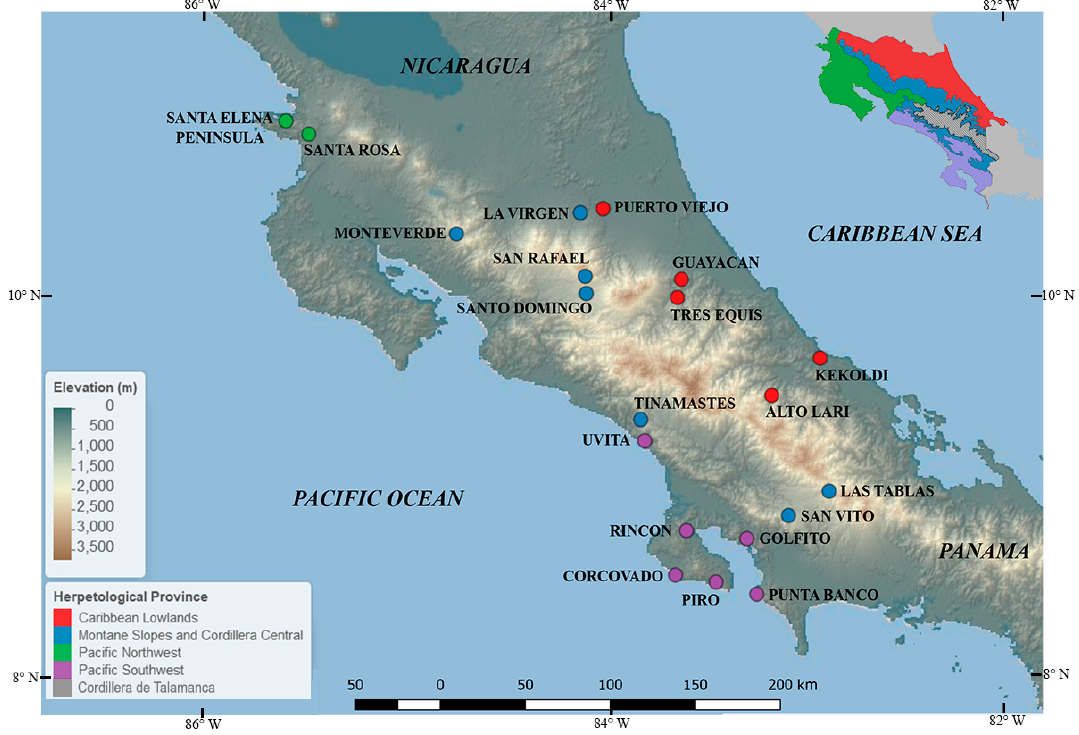
Figure 1. Map of 20 survey sites across Costa Rica. Sites are color-coded by herpetological province.